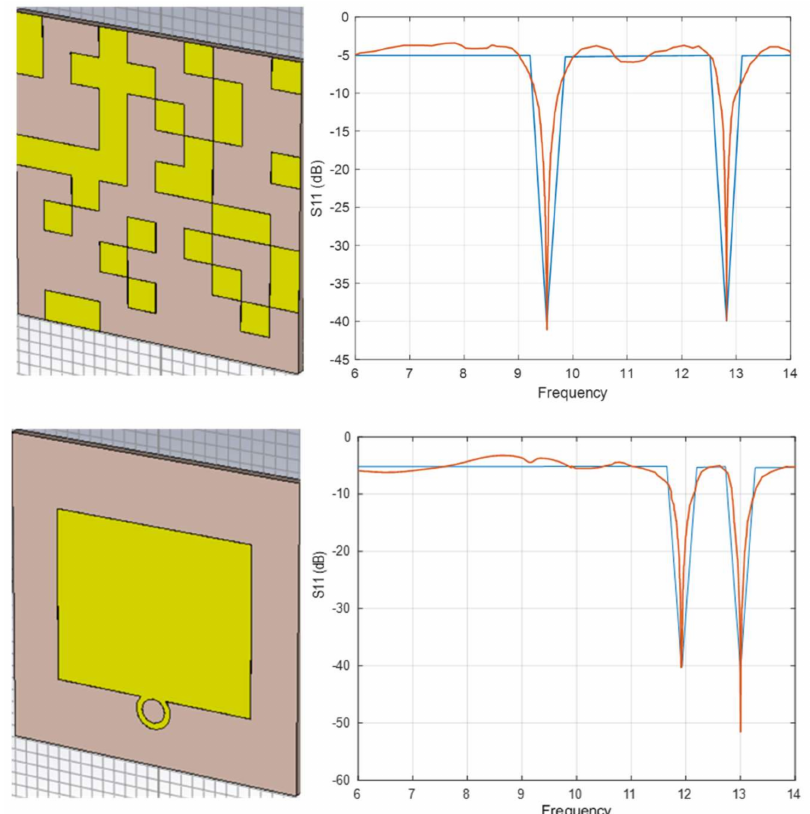
Figure 8. 6 Random examples: the blue line is desired reflection coefficients, orange line generated image by the nested-CNN’s result based on simulation program.